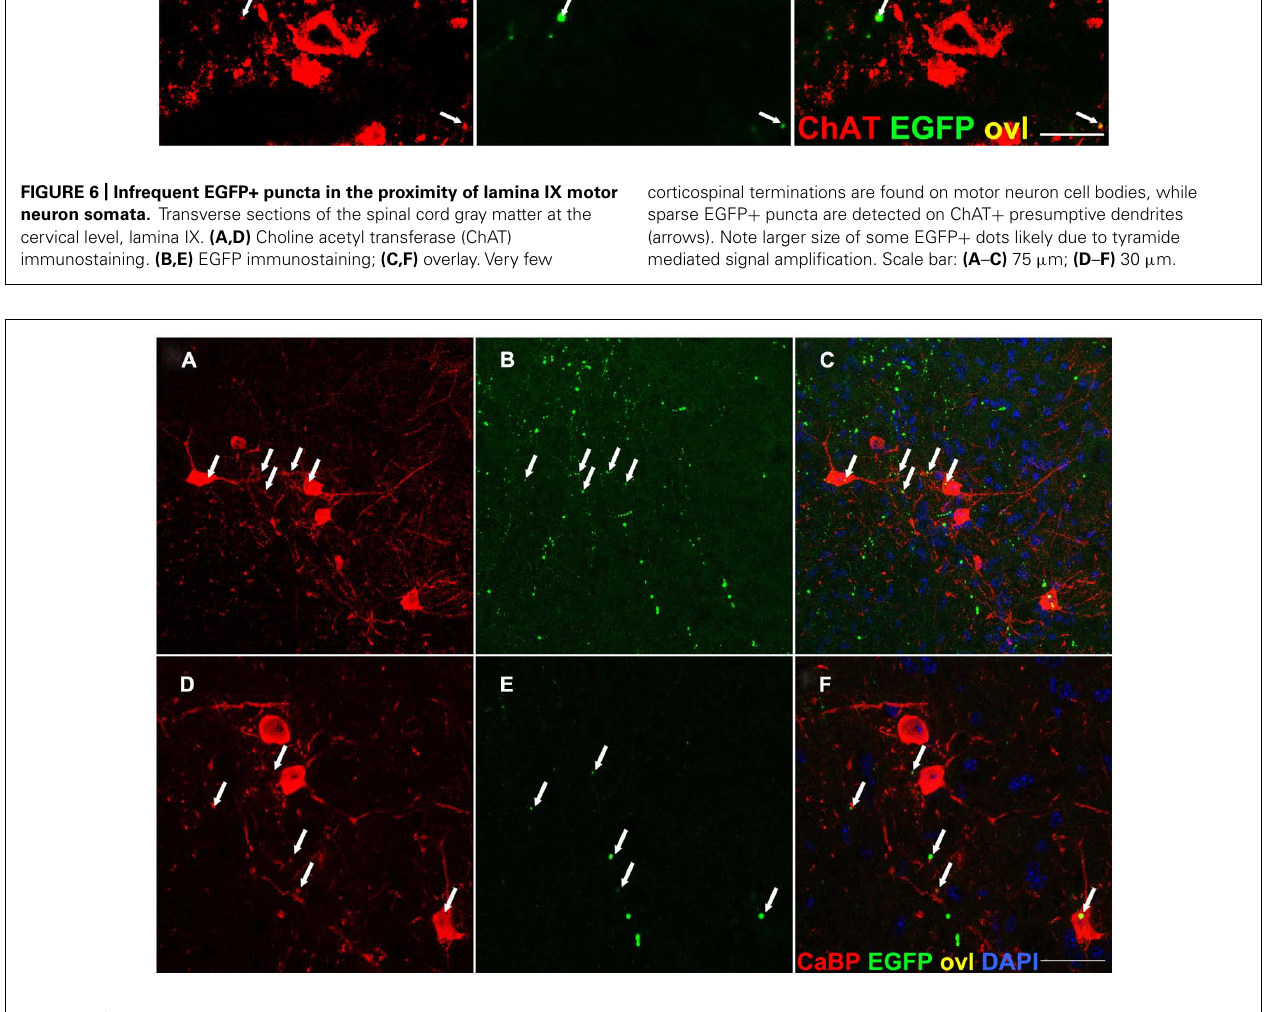
FIGURE 7 | EGFP+ presynaptic terminals are detectable on calbindin-IR neurons in lamina VII. Transverse sections of the spinal cord gray matter at the cervical level, lamina VII. EGFP + axon terminals (arrows in B,E ) are detected on the soma and dendrites of